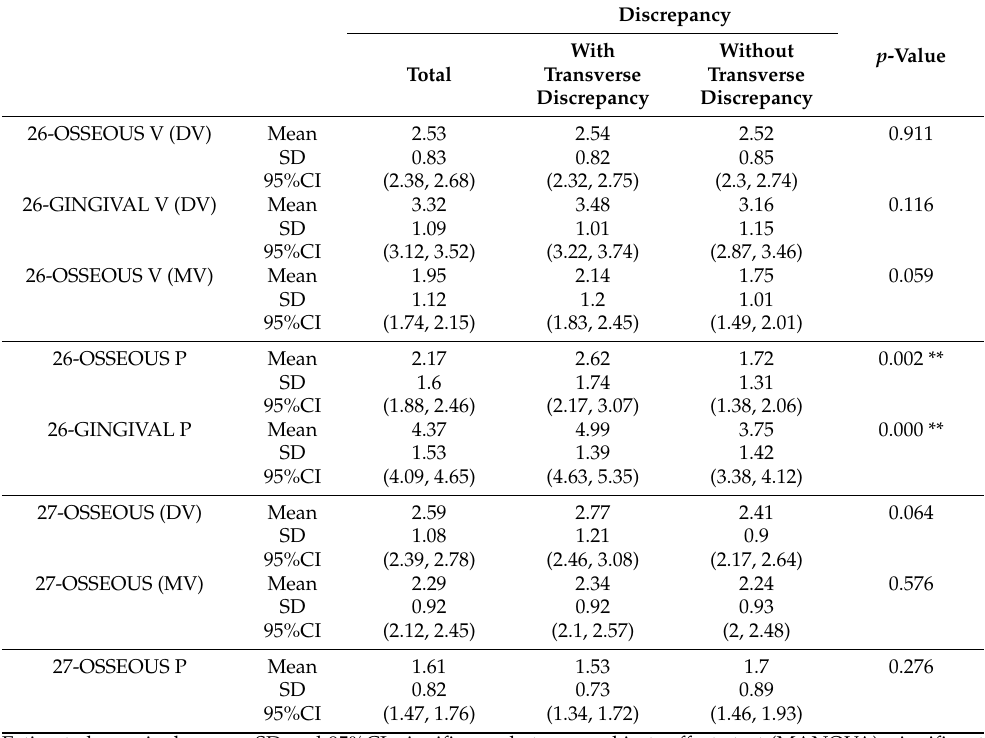
Table 5. Linear measurements corresponding to upper left molars in the presence and absence of transverse bone